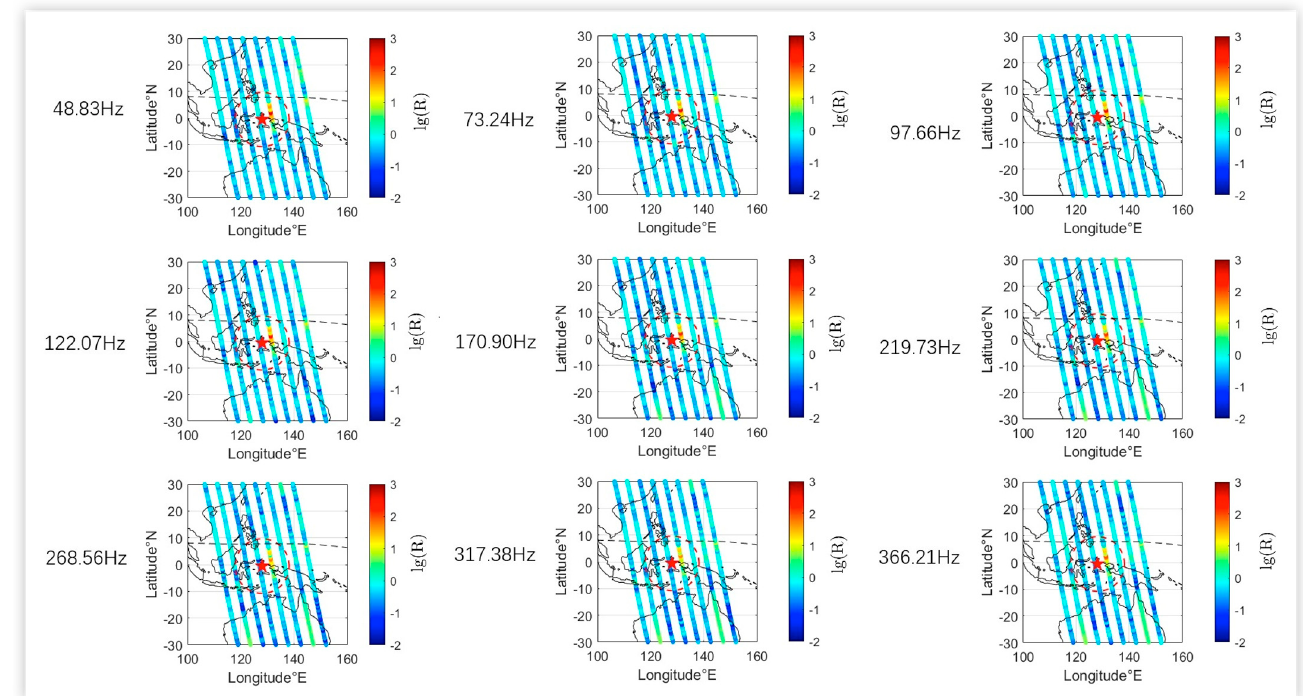
Figure 5. Similar to Figure 4, using the earthquake No. 2 as the object, the relative values of the electric field PSD on ascending orbits from 11 July to 15 July. From left to right, the dotted lines indicate the satellite trajectories on 13, 14, 15, 11, 12, 13, 14, and 15 July, respectively.